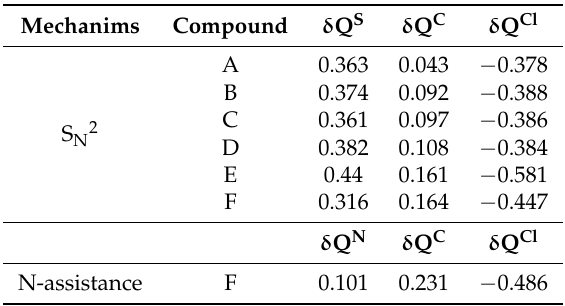
Table 4. Charge changes, δ Q x ( x = S, C, or Cl), through the reaction pathway.